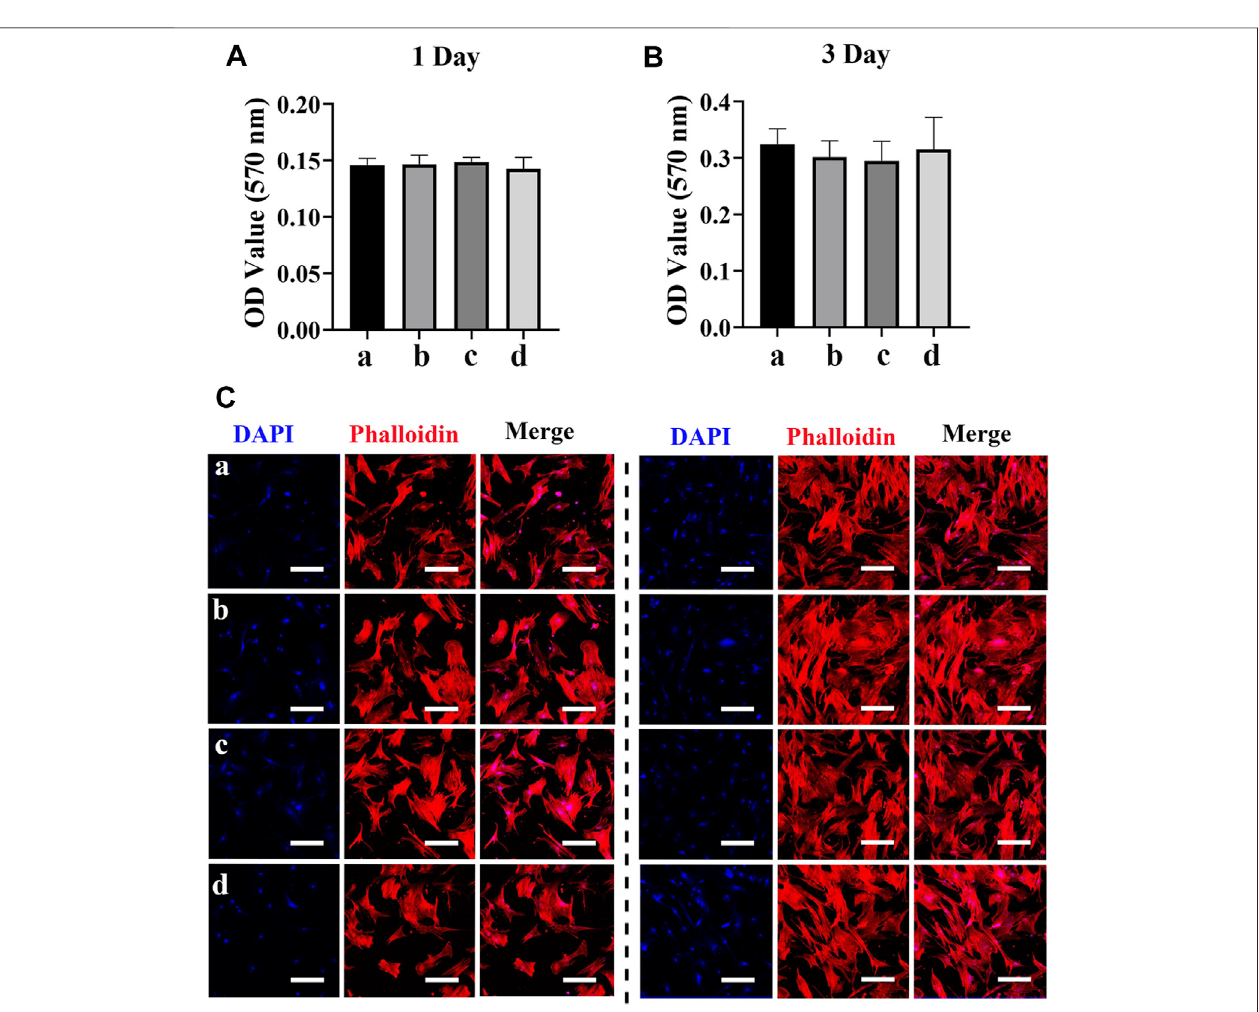
FIGURE 5 | Effect of the exosome and Ag hybrid scaffold on hBMSC proliferation. (A,B) Metabolic activity of hBMSCs was assessed by the MTT assay. Cell proliferation was evaluated by the MTT assay at 1 and 3 days. a (cid:2) PCL/PDA, b (cid:2) PCL/PDA+Ag, c (cid:2) PCL/PDA+exosome, and d (cid:2) PCL/PDA+Ag+exosome. Data were presented as mean ± SD ( n (cid:2) 5). (C,D) Representative confocal microscopy images of hBMSCs at 1 day (C) and 3 days (D) . Cells were stained by Alexa Fluor 594- conjugated phalloidin and DAPI and were examined by confocal microscopy. Scale bars (cid:2) 200 μ m. Effect of the exosome and Ag hybrid scaffold on hBMSC osteogenic